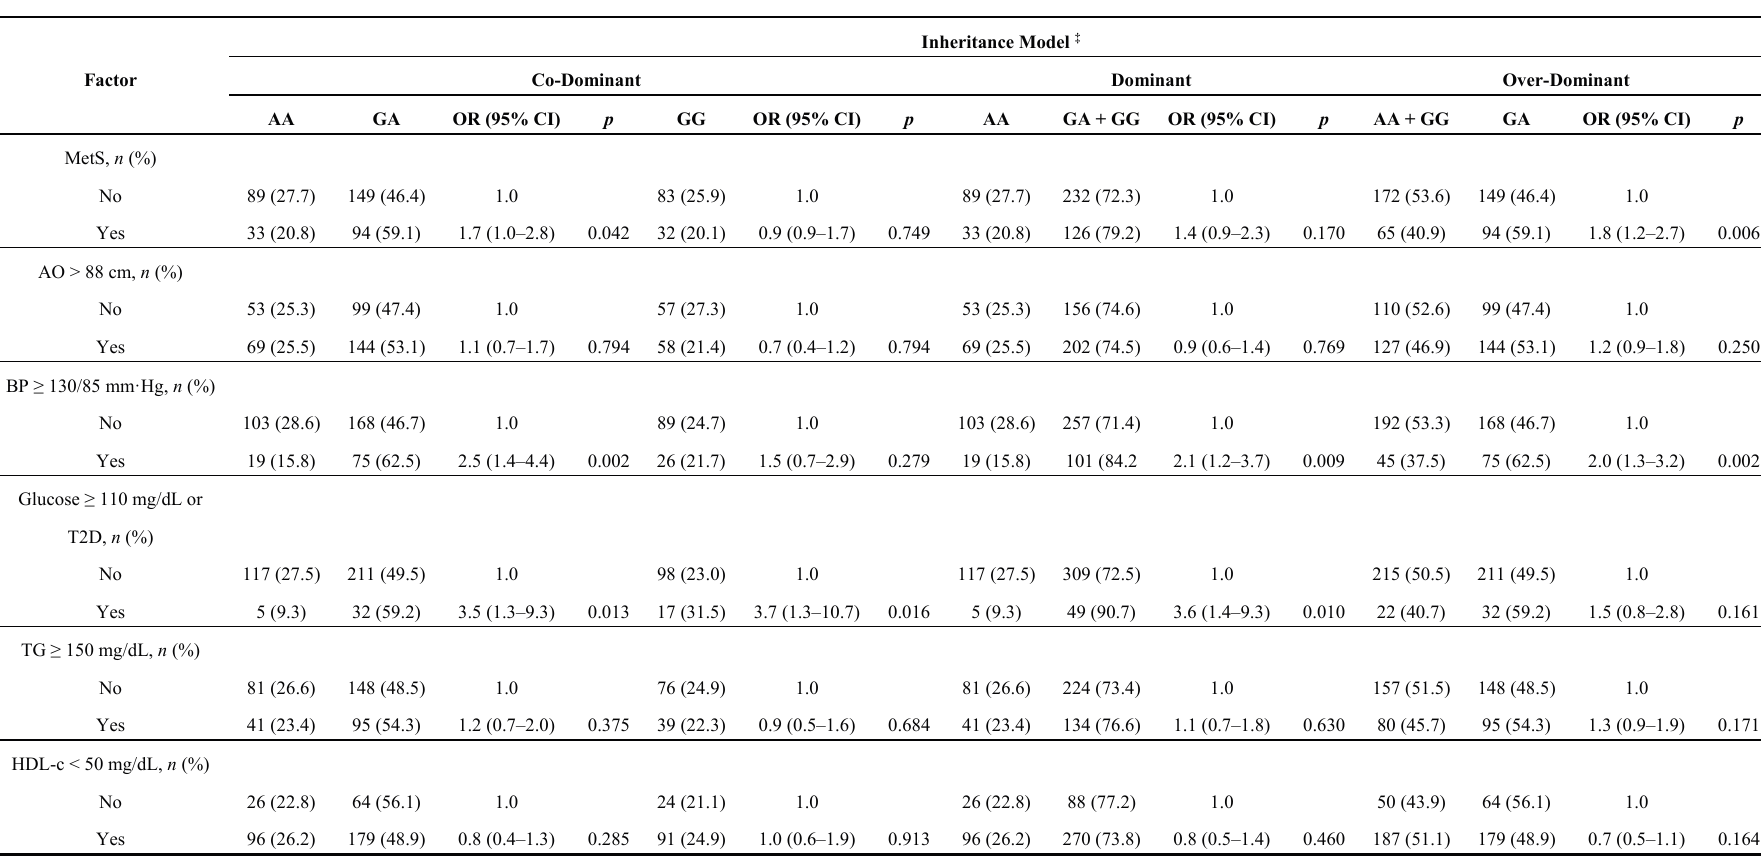
Table 5. Association between SNP rs708272 in CETP gene with MetS and their